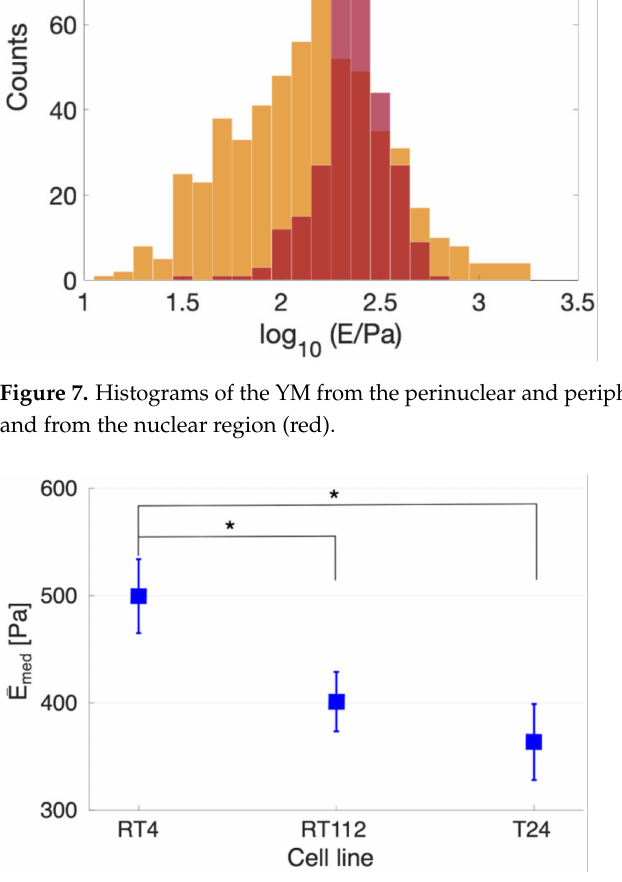
Figure 8. The Young’s modulus (whole cell) measured by AFM for bladder cancer cells RT4, RT112, and T24, with increasing grades of invasiveness (left to right). * Means p <